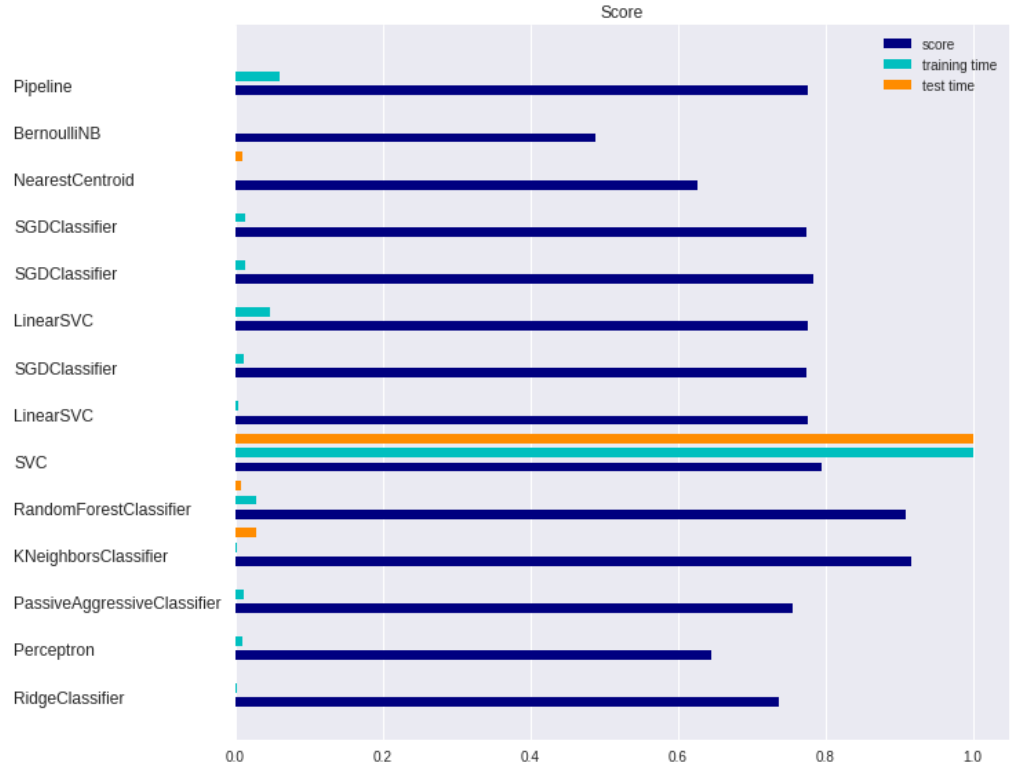
Figure 11. Benchmark of 14 different classification algorithms for the same dataset.